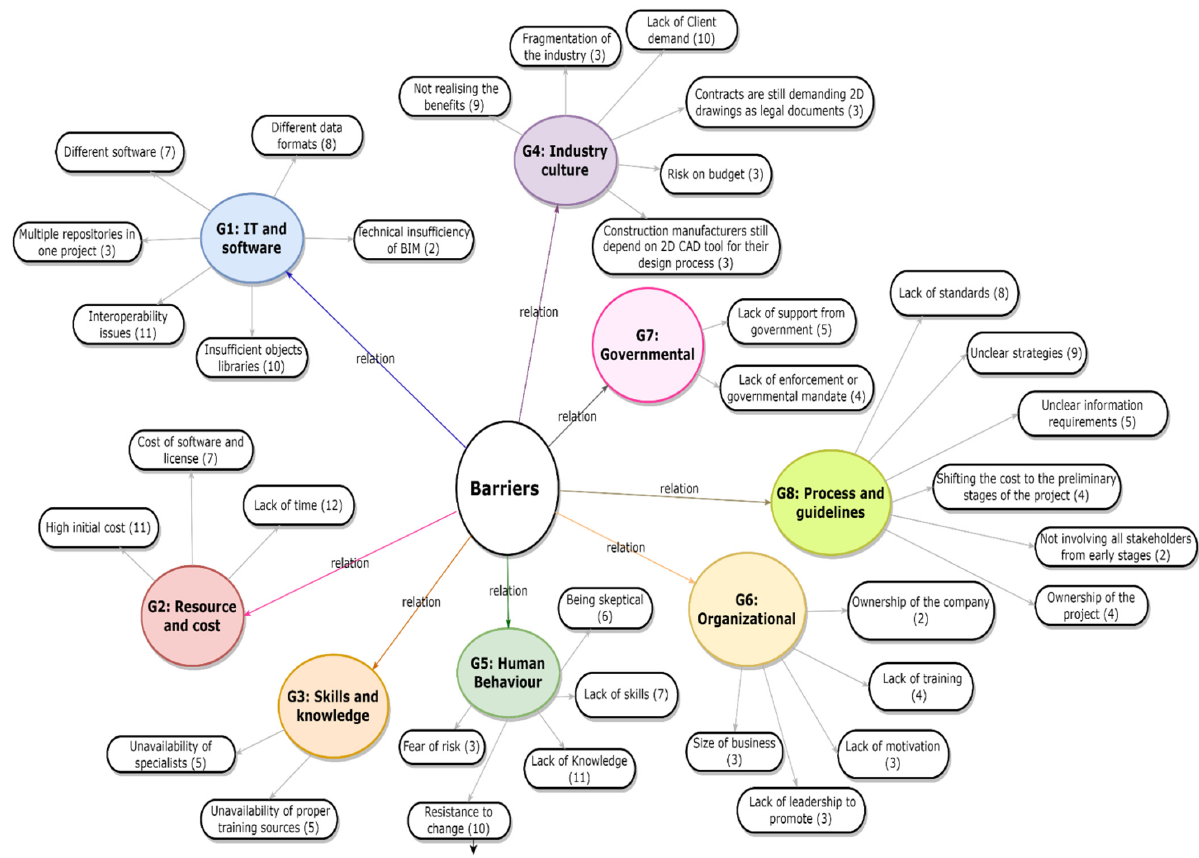
Figure 2 . Coding map, Codes, Groups, and Categories . Figure 2. Coding map, Codes, Groups, and